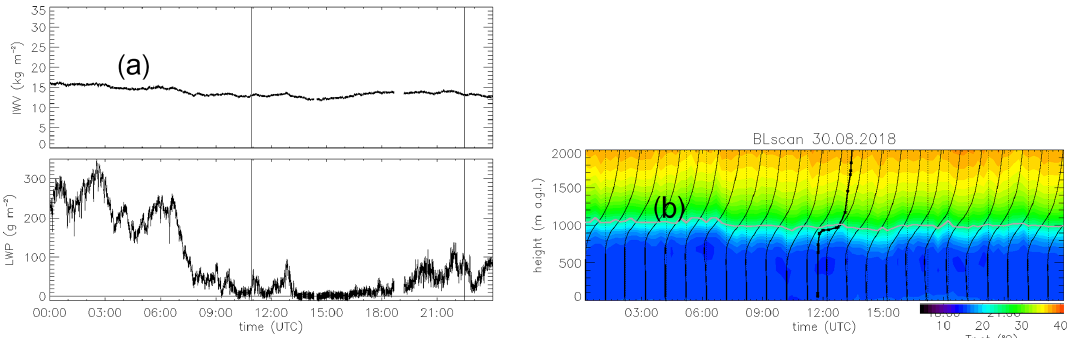
Figure A2. Example data from 30 August 2018. (a) LWP and IWV from the microwave radiometer on the basis of the TH85 retrieval. (b) Potential temperature profiles from the microwave radiometer (color shading, and thin smooth lines at times indicated by dotted vertical lines) and the Antofagasta radiosonde profile for that day (thick line with symbols around 12:00UTC). The thick gray line indicates the height of the strongest gradient. Vertical lines indicate the times of sunrise and sunset.